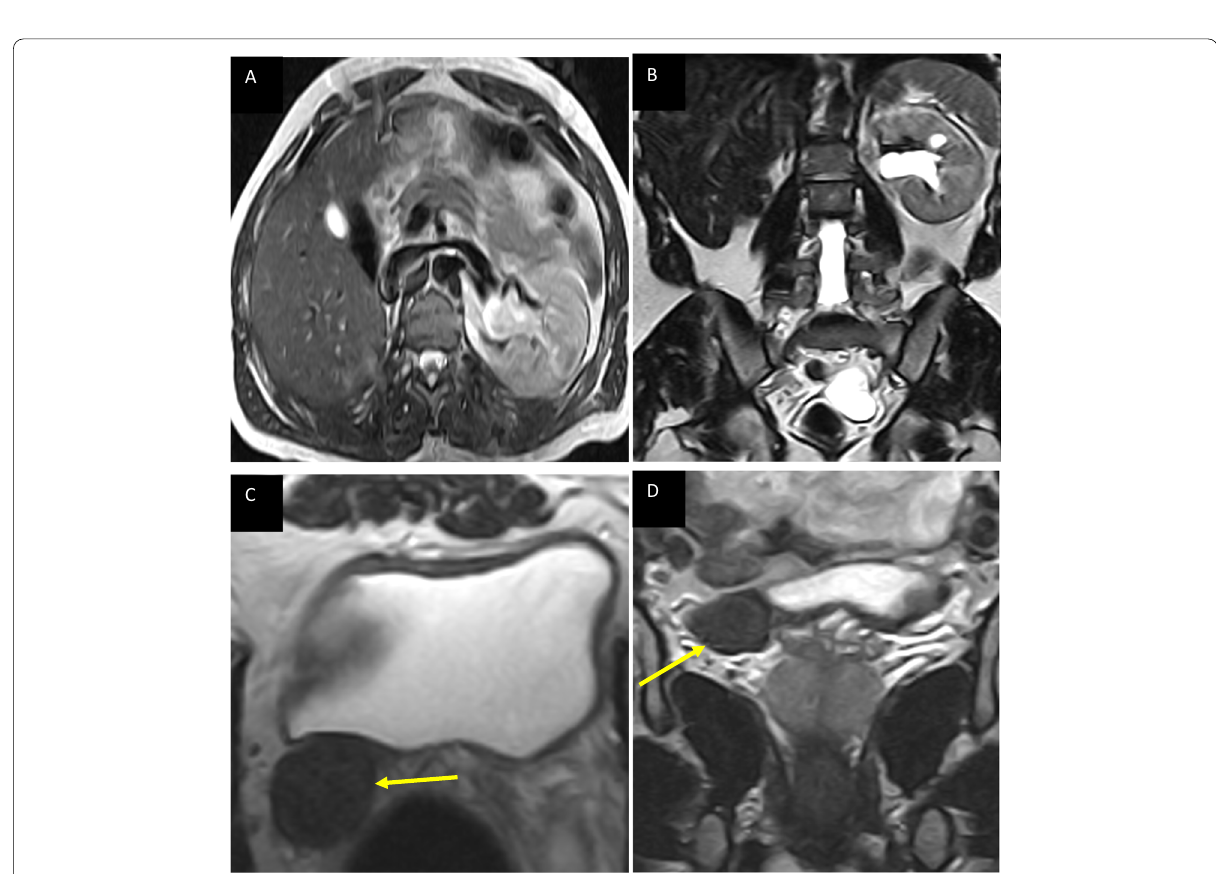
Fig. 4 A Axial T2WI of the abdomen and B coronal T2WI of the abdomen and pelvis show mild left hydronephrosis with dilated renal pelvis and non‑dilated ureter suggesting PUJ narrowing as well as right renal agenesis, C – G high‑resolution axial, coronal and right parasagittal T2WI of the pelvis revealed normal left SV and right SV cyst (yellow arrow) measured (1.7 1.3 cm) as well as presence of right sided pelvic cystic tubular × structure (red arrow) seen connected with the dilated right SV which resembles right rudimentary ureteric bud with abnormal insertion into right SV, both the cyst and the tubular structure display low T2WSI and high T1WSI (not shown) denoting hemorrhagic or high proteinaceous